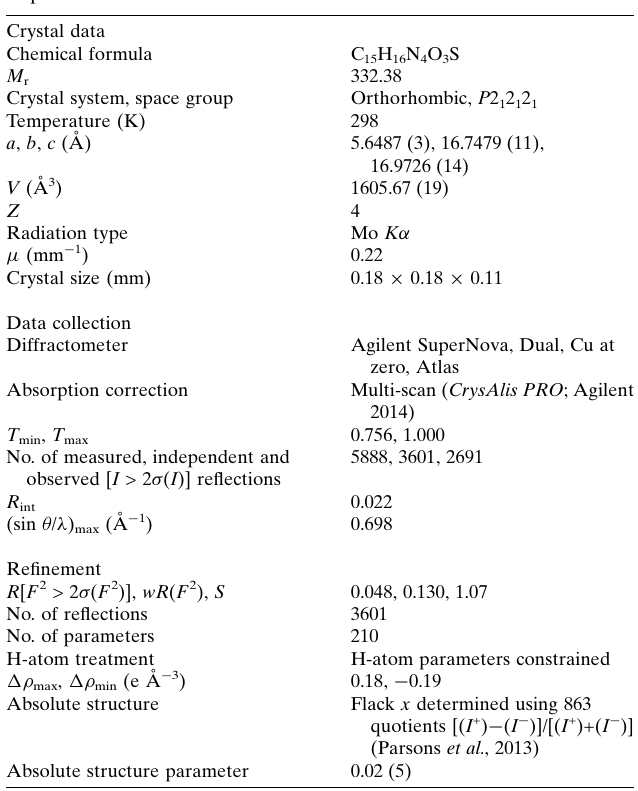
Table 2 Experimental details.